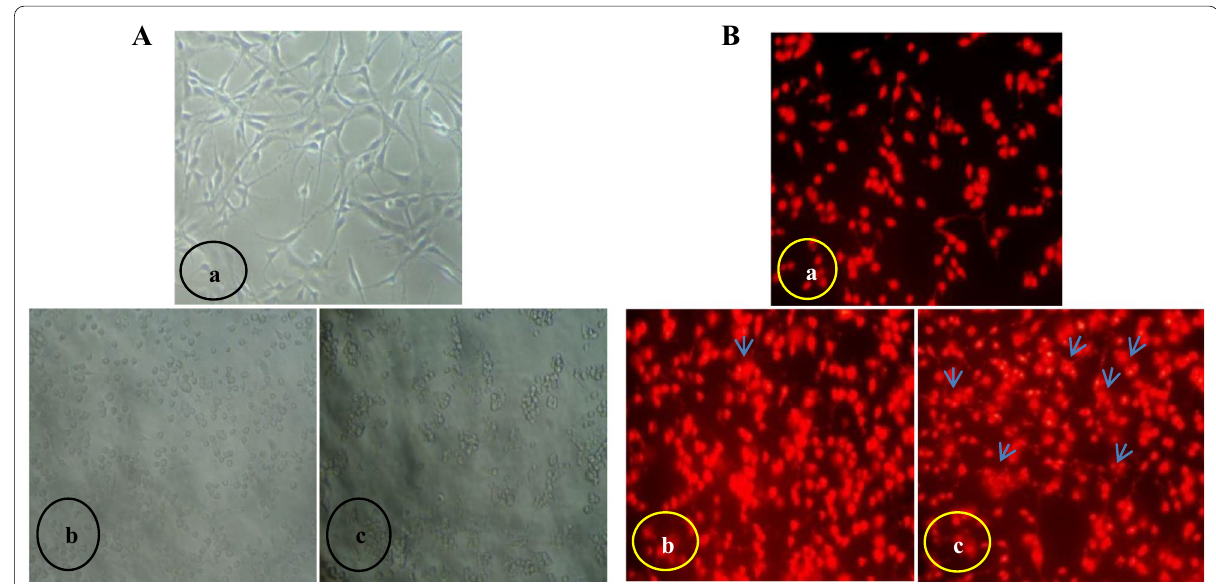
Fig. 4 Effect of venom protein (fraction 1) on Morphological changes in C6 cells. A Cytomorphological changes of C6 cells at 24 h incubation. Scale bar 20x. (A) Control cells. (B) Low concentration (50 µg/ml). (C) High concentration (150 µg/ml). B Effect of venom protein (fraction 1) on nuclear changes of C6 cells at 24 h incubation. Scale bar 20x. (A) Control cells. (B) Low concentration (50 µg/ml). (C) High concentration (150 µg/ml). The arrow mark represents nuclear